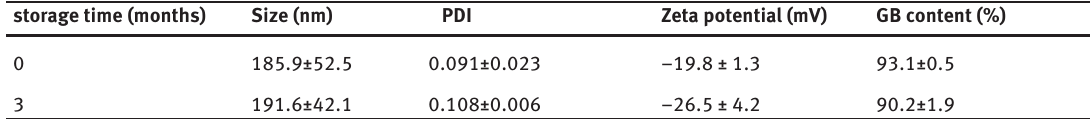
Table 7: Stability of fat emulsion stored at room temperature for three months.